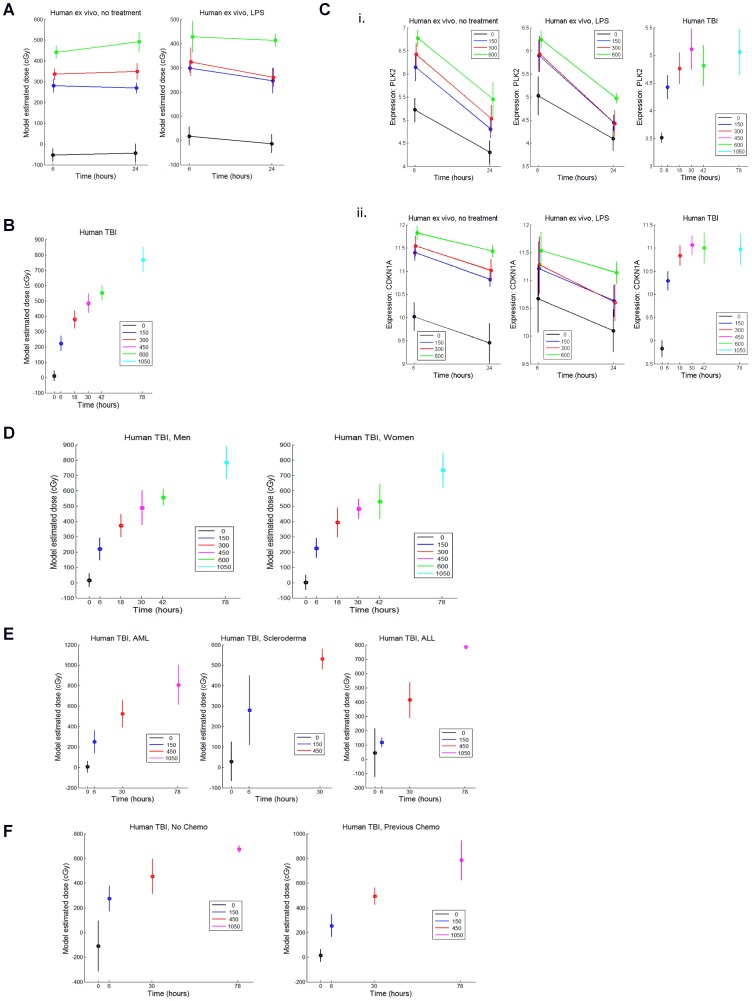
A radiation classifier generated from human genes predicts human radiation exposure with high accuracy.A) At left, the mean +/− SEM estimated radiation doses of human PB cells are plotted on the y axis at 6 hrs and 24 hrs of culture (x axis) following ex vivo irradiation. At right, identical radiation dose prediction is shown in the presence of LPS. Green line: 600 cGy, Red line; 300 cGy, Blue line: 150 cGy, Black line: 0 cGy. B) The mean +/− SEM estimated radiation dose levels of human PB from TBI patients are plotted on the y axis. The x axis shows the time points after initial TBI dose at which the PB sample was collected from the patient. PB was collected at 6 hours following the first fraction of TBI (150 cGy) and 12 hours later (18 hr time point, following the 2nd fraction = total 300 cGy) and so on. TBI was delivered in a standard fractionated manner to patients, twice daily (150 cGy separated by 6 hours) and so these time points were fixed by the clinical treatment protocol. The legend shows the actual cumulative radiation dose received at each time point. C) The responses of individual human genes, PLK2 and CDKN1A, are shown in response to ex vivo irradiation and TBI. Panel i. Expression of PLK2 is shown on the y axis at 6 hours and 24 hours after ex vivo irradiation, with and without LPS (left); at right, the expression of PLK2 is shown in the PB samples of TBI patient samples at the radiation dose levels shown. Panel ii. Expression of CDKN1A is shown in ex vivo irradiated human PB samples, with and without LPS (left); at right, the expression of CDKN1A is shown in human TBI patient samples at different radiation dose levels. D) The model estimated radiation dose levels for the human TBI patient samples are shown on the y axis, separated by gender. The actual radiation dose levels are indicated in the legend. The x axis shows the time points at which PB samples were collected. E) The model estimated radiation dose levels for the human TBI patient samples are shown on the y axis, separated by the diagnoses, acute myeloid leukemia (AML), scleroderma, and acute lymphocytic leukemia (ALL). Note that for some diagnostic groups, not all radiation dose levels are represented. F) The model estimated radiation dose levels for human TBI patient samples are shown on the y axis, separated by “no chemotherapy” or “previous chemotherapy.”